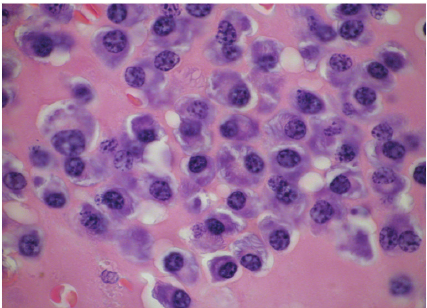
Figure 3: Plasma cells presented eccentric nuclei and atypical cytology (prominent nucleoli, dispersed nuclear chromatin, and high nuclear-cytoplasmic ratio).